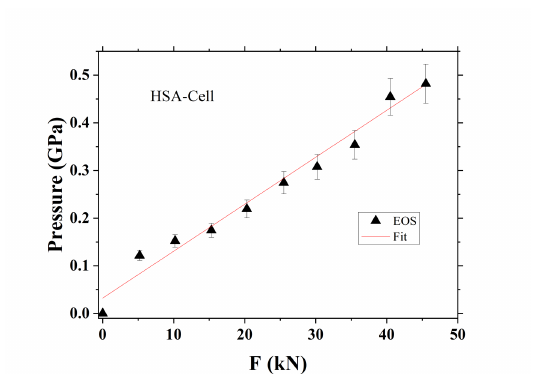
Fig. 3. The pressure calibration curve for the Hybrid- Cell.